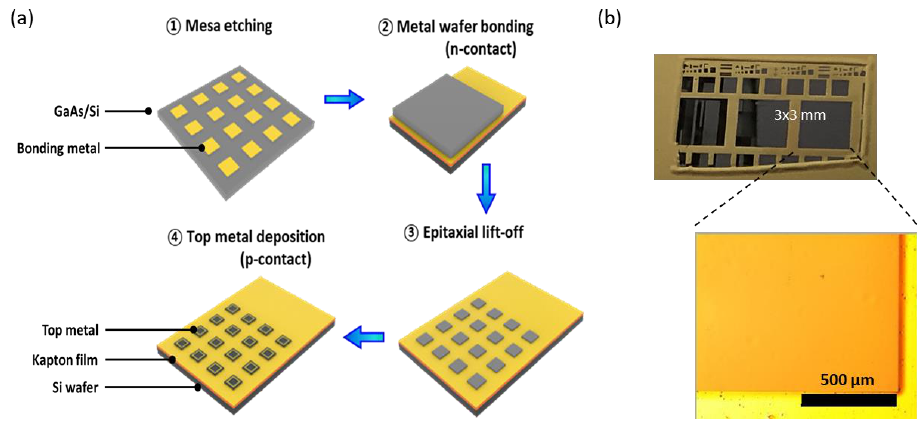
Figure 4. ( a ) Fabrication procedure for transfer process of GaAs solar cell. ( b ) Photograph of trans- ferred GaAs solar cell to polyimide. The inset shows the optical microscope image of GaAs solar cell grown on Si